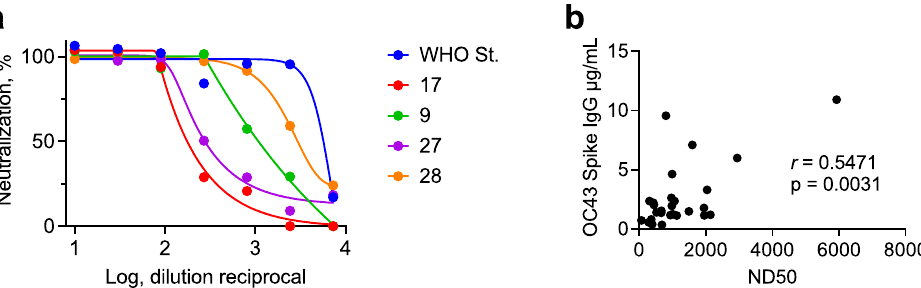
Figure 4. Measurement of OC43 neutralizing antibody titers in plasma using a micro-neutralization assay. ( a ) Plasma from assay. ( a ) Plasma from healthy adult donors was serially diluted and incubated with 50 TCID 50 of healthy adult donors was serially diluted and incubated with 50 TCID 50 of OC43 for one hour and adsorbed onto mono-